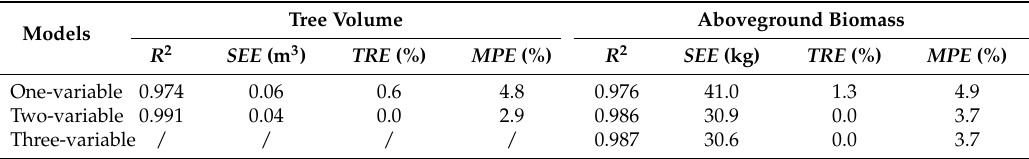
Table 4. Goodness-of-fit statistics for compatible tree volume and aboveground biomass equations.